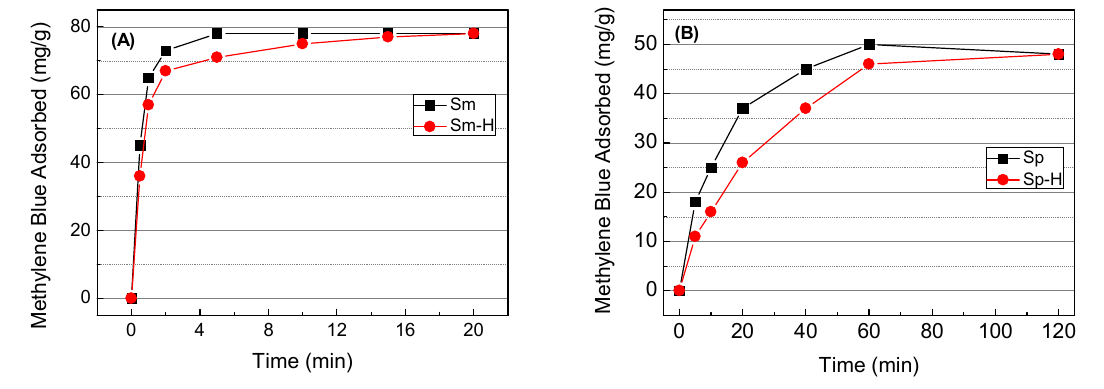
Figure 8 . Kinetics of methylene blue adsorption in natural Mg-smectite (Sm) and sepiolite (Sp), and Figure 8. Kinetics of methylene blue adsorption in natural Mg-smectite (Sm) ( A ) and sepiolite (Sp) ( B ), in the acid activated materials. and in the acid activated